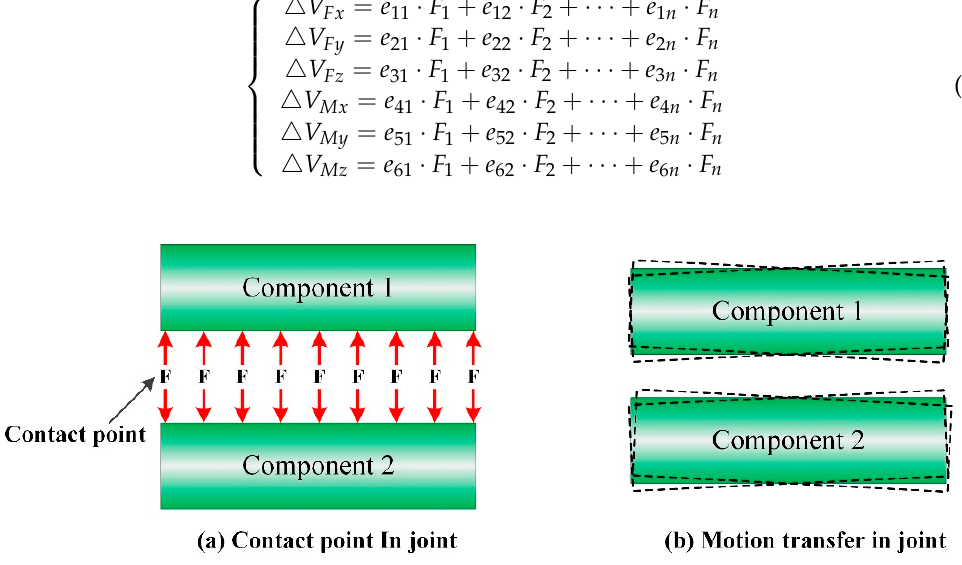
Figure 7. The position of contact point in